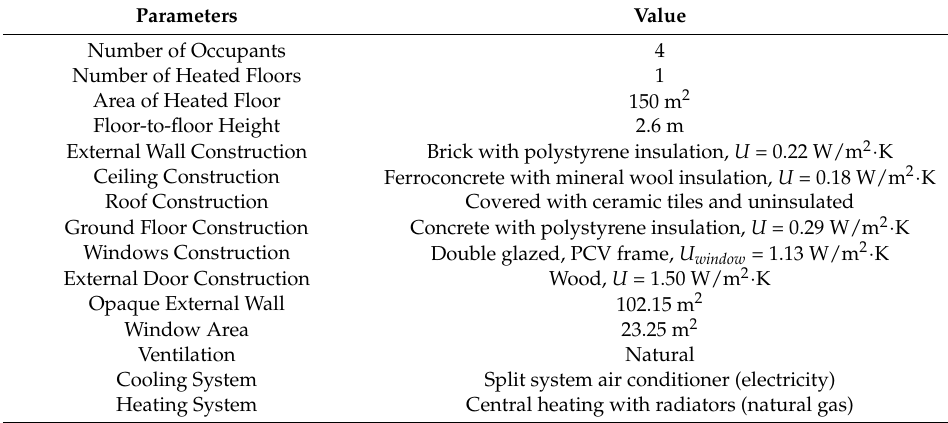
Table 2. Characteristics of the reference building.